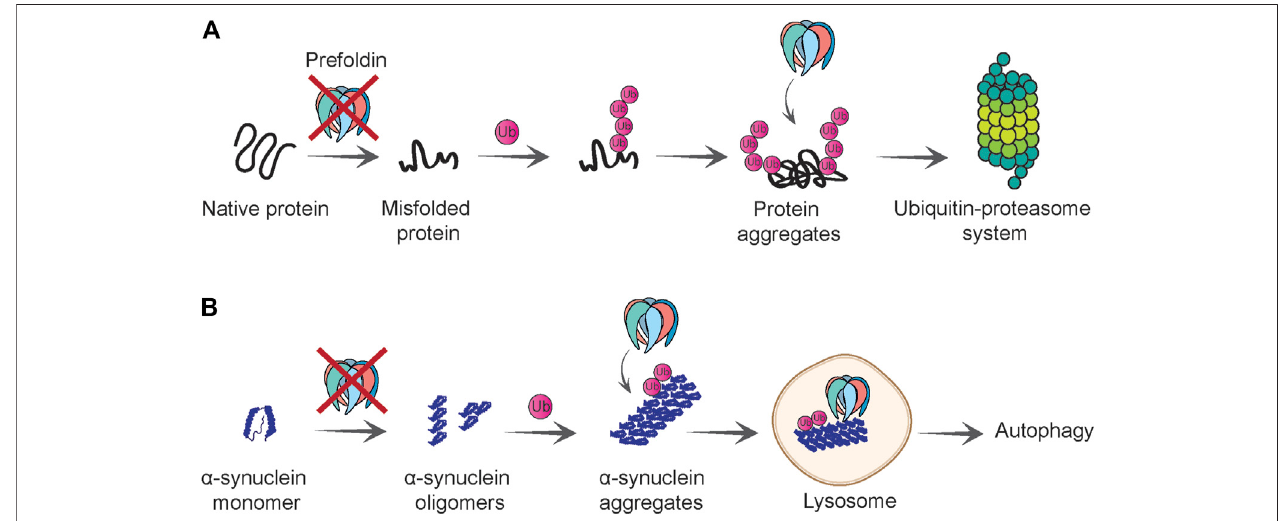
FIGURE 4 | Role of prefoldin complex in protein quality control and degradation. (A) Prefoldin is required for polypeptides to gain native fold and loss of prefoldin function causes protein misfolding. Misfolded proteins that cannot be refolded are polyubiquitinated. Prefoldin complex co-localizes with the polyubiquitinated proteins and presumably facilitates their degradation by the ubiquitin-proteasome system. (B) Prefoldin complex prevents aggregation of α -synuclein at initial steps of oligomerization. If α -synuclein oligomers form aggregates, they will be ubiquitinated and in proximity to prefoldin complex delivered to the lysosome in which aggregates can be degraded in an autophagy-dependent